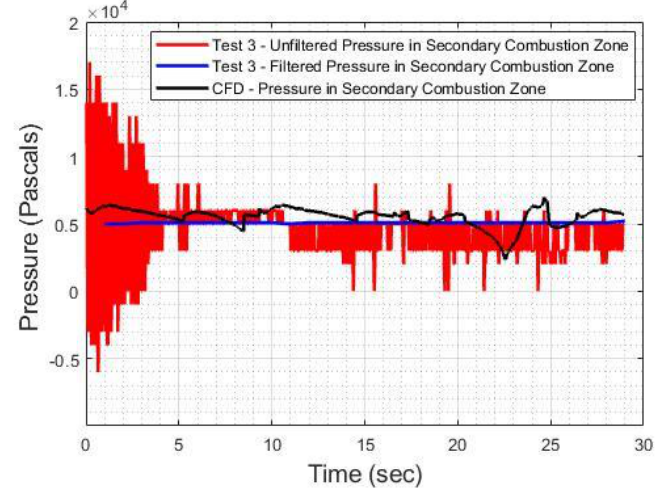
Figure 21. Comparison of Secondary Combustion Pressure.